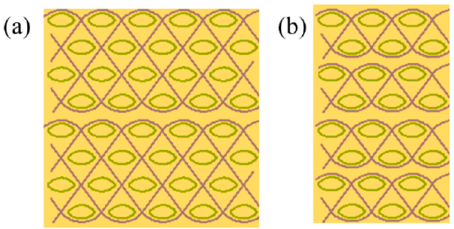
Figure 1. Multiply fabric reinforced composite panels: ( a ) 2-ply 3D woven 4-layer TTAI reinforced composite; and ( b ) 4-ply 2D plain weave fabric reinforced composite.